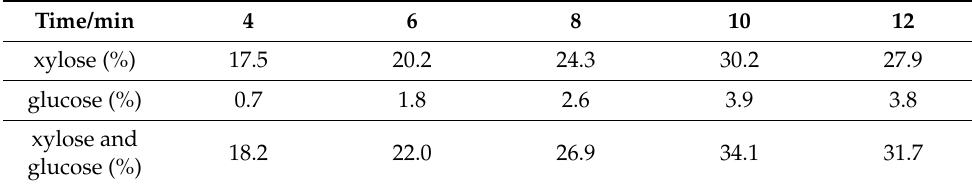
Table 4. Effect of time on xylose and glucose yield in the first step.